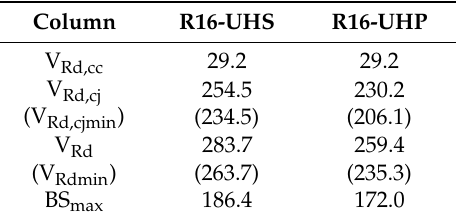
Table 6. Repaired column shear strength: concrete core contribution (V Rd,cc ), concrete jacket contribution (V Rd,cj ), column shear strength (V Rd ), minimum values of the jacket contribution (V Rd,cjmin ), and of the shear strength (V Rdmin ).